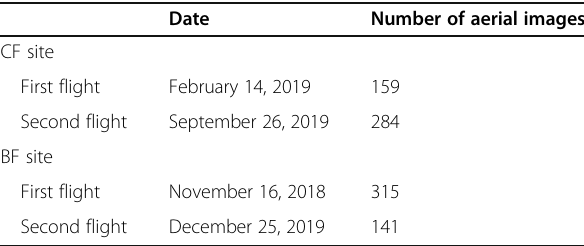
Table 2 Dates of UAV flights and number of aerial images used to provide